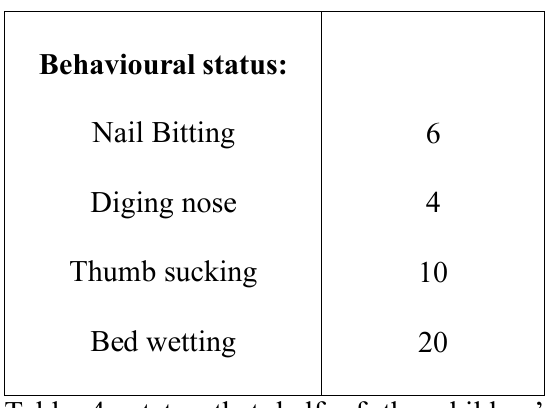
Table 4: Behavioural status (n=40)